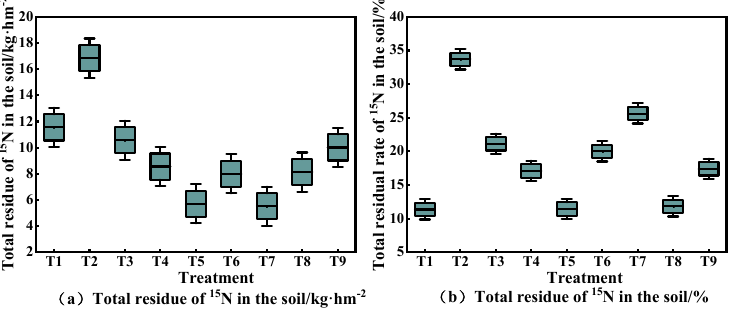
Figure 2. Total residual amount and total residual rate of 15 N fertilizer in 0–15 cm soil under different treatments.